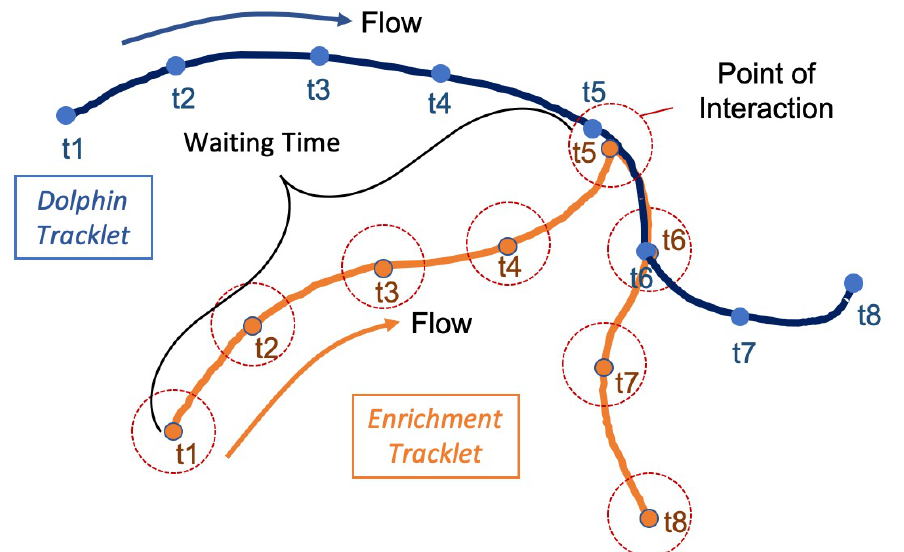
Figure 3. An illustration of how waiting time was defined for the enrichment. Eight time steps are shown for a dolphin (blue) and a piece of enrichment (orange). A point of interaction occurs at t5 when the dolphin detection is within 2 m of the enrichment at the same time. The waiting time is then defined as the time from the initial detection (t1) to the point of interaction